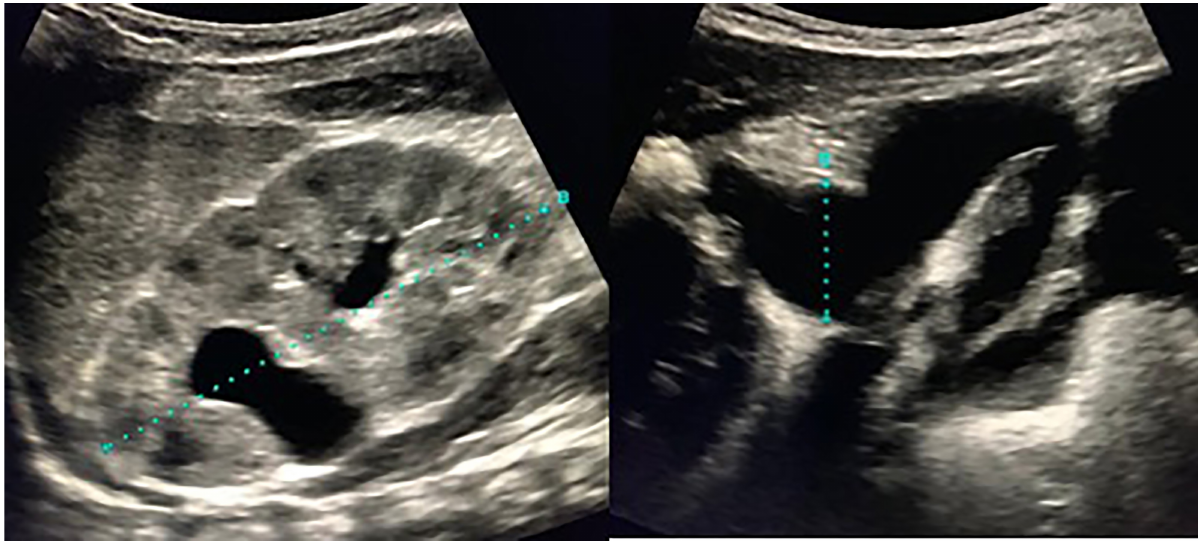
Figure 1 - Preoperative ultrasound demonstrating severe hydroureter and hydronephrosis to the upper pole moiety of a duplex collecting